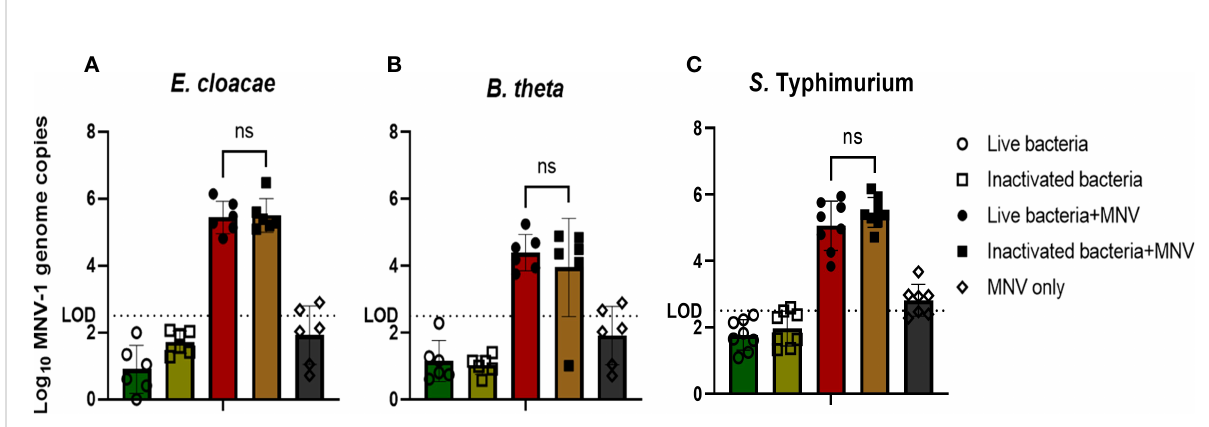
FIGURE 1 MNV binds to live and inactived bacteria at similar levels. (A) E cloacae , (B) B thetaiotaomicron , and (C) S. Typhimurium were incubated at room temperature (live) or at 65°C (heat inactivated) for 40 mins and subsequently incubated with MNV for 1 hr. After 2 washes of the bacterial pellet, MNV was quanti fi ed by RT-qPCR (n ≥ 6). T-test with Welsch ’ s correction was done to detect signi fi cant changes in MNV attachment to live vs. inactivated bacteria. (ns= not signi fi